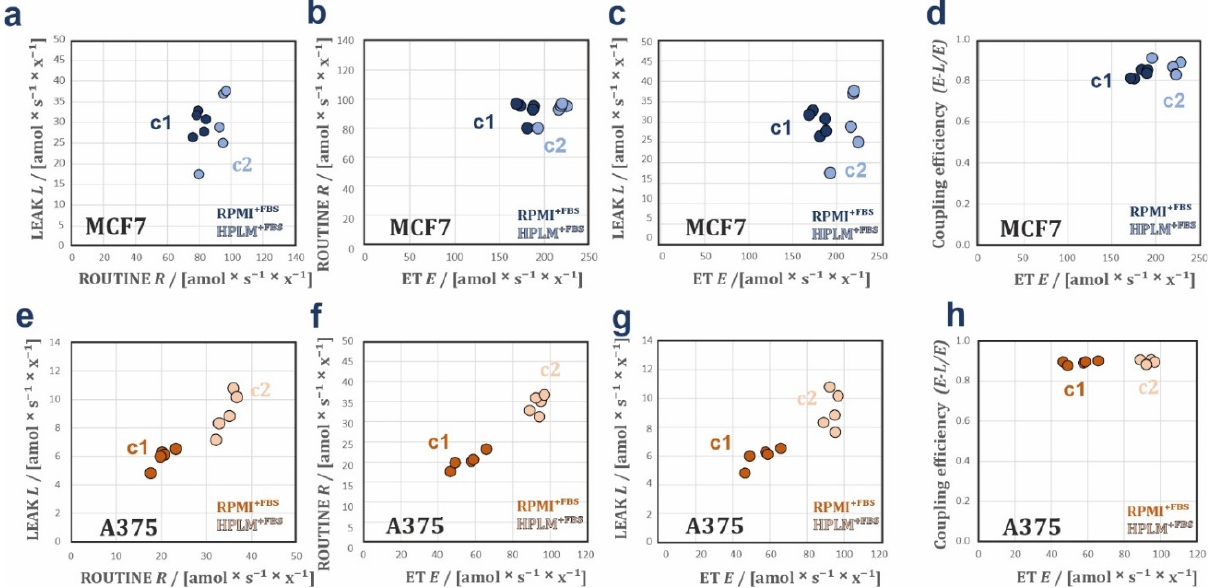
Figure 4. Bioenergetic cluster analyses in different respiratory coupling states of the SW620, MCF7, and A375 cell lines. BCA plots of steady state conditions ( a – h ). Plots of L over R , R over E , and L over E . ( a – c ) MCF7 showing two heterolinear bioenergetic clusters in RPMI +FBS (c1) and HPLM +FBS (c2). This indicates changes in mitochondrial quality between both media. ( e – g ) A375 showing two isolinear bioenergetic clusters in DMEM +FBS (c1) and HPLM +FBS (c2). Proportionality with zero intercept indicates changes of mitochondrial density in the cells grown in the two media. ( d , h ) Coupling efficiencies ( E - L )/ E over ET capacities in, MCF7 ( d ) and A375 ( h ). The lower ( E - L )/ E values in MCF7 cells in RPMI +FBS at lower ET values indicate a drop in mitochondrial quality with RPMI +FBS . In A375, the ( E - L )/ E values remain constant over ET in both media indicating that mitochondrial quality is